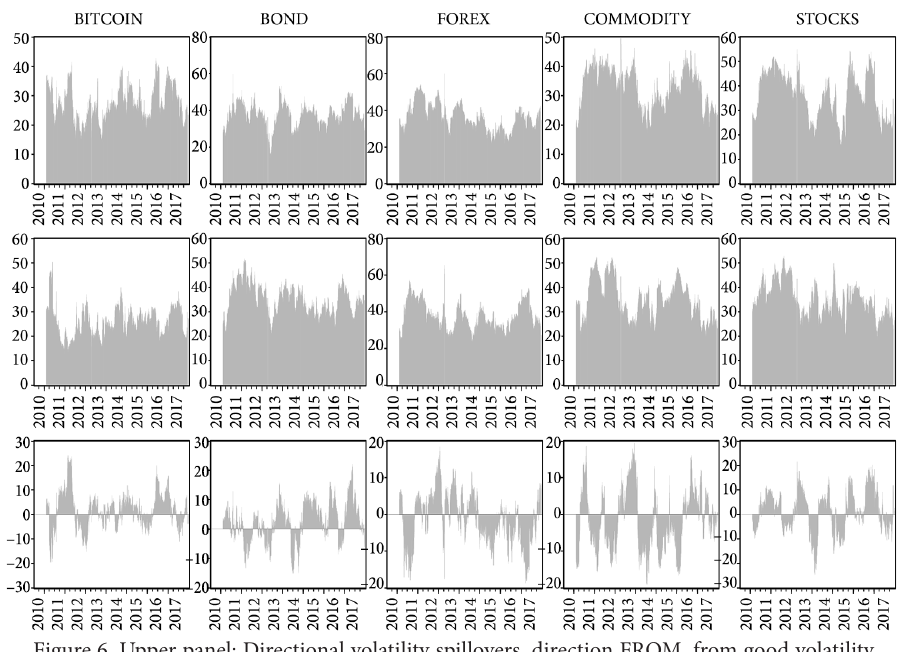
Figure 6. Upper panel: Directional volatility spillovers, direction FROM, from good volatility, middle panel: directional spillovers, direction FROM, from bad volatility, lower panel: the directional spillover asymmetry measures 2 , H N i SAM ←•